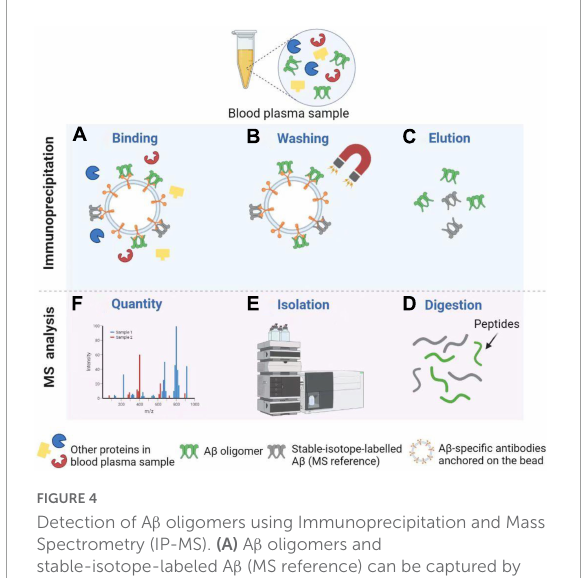
FIGURE4 Detection of A β oligomers using Immunoprecipitation and Mass Spectrometry (IP-MS). (A) A β oligomers and stable-isotope-labeled A β (MS reference) can be captured by A β -specific antibodies anchored on the bead. (B) After washing, other proteins in the blood plasma sample are removed from the solution. (C) Next, A β oligomers and MS reference can be separated from the bead for further MS analysis. (D,E) After enzymatic digestion, peptides are isolated by High Performance Liquid Chromatography (HPLC). (F) Finally, MS profiles can be obtained to carry out the A β oligomer quantity. Illustrations were generated using